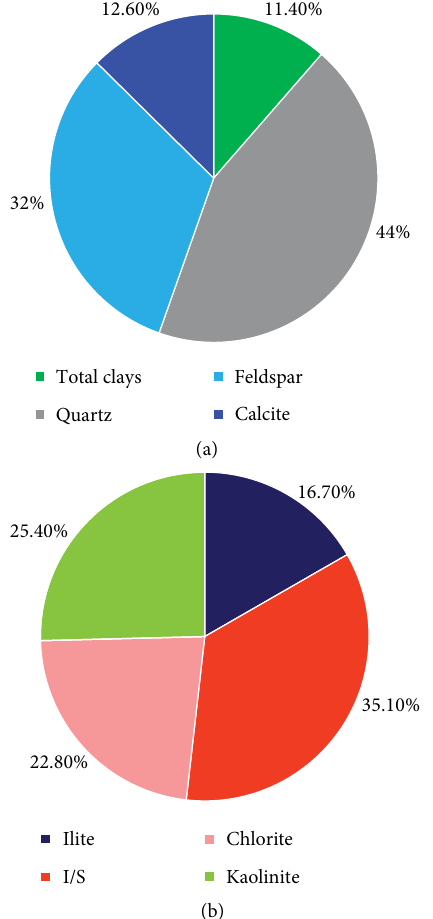
Figure 1: The mineralogy composition of samples: (a) bulk mineral composition, (b) clay mineral composition.